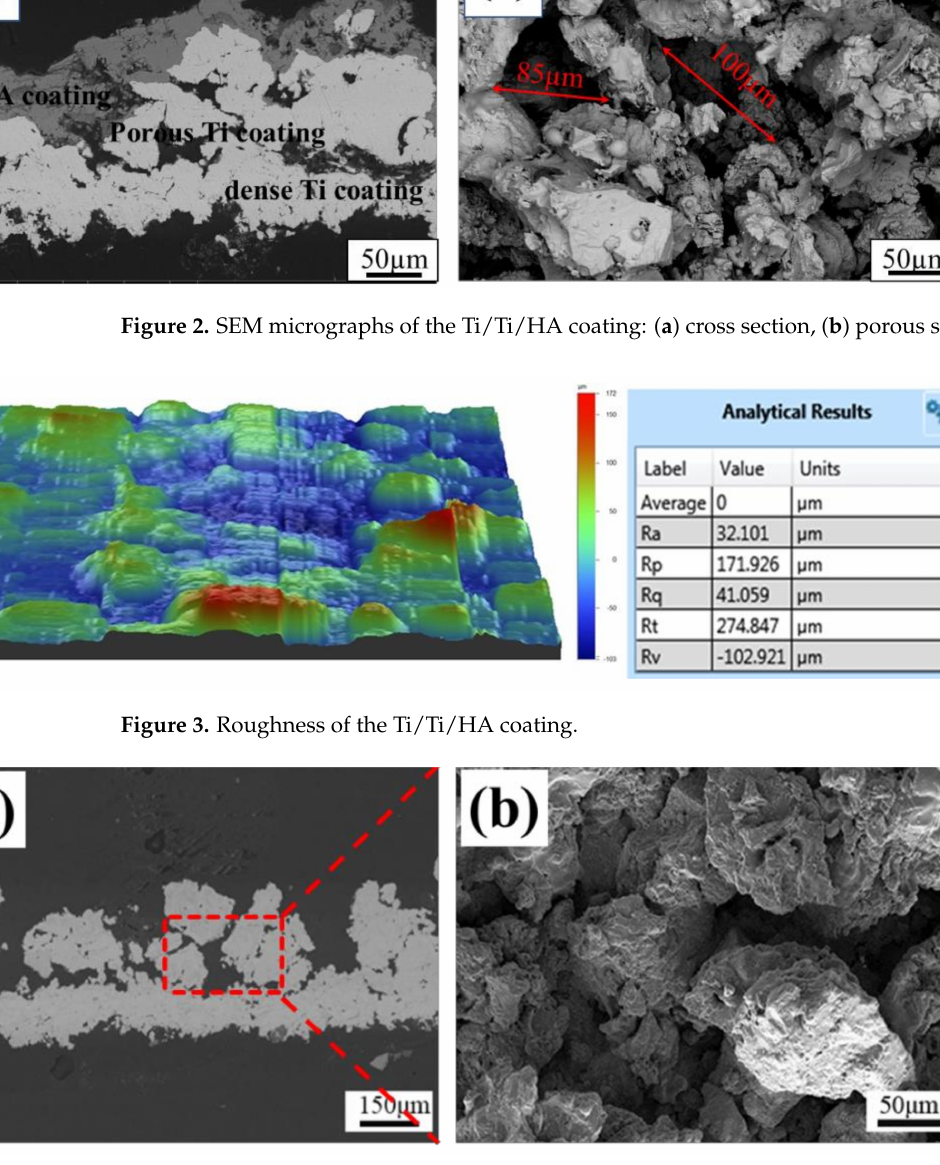
Figure 4. Morphology of the Ti/Ti coating: ( a ) cross section, ( b ) porous structure.